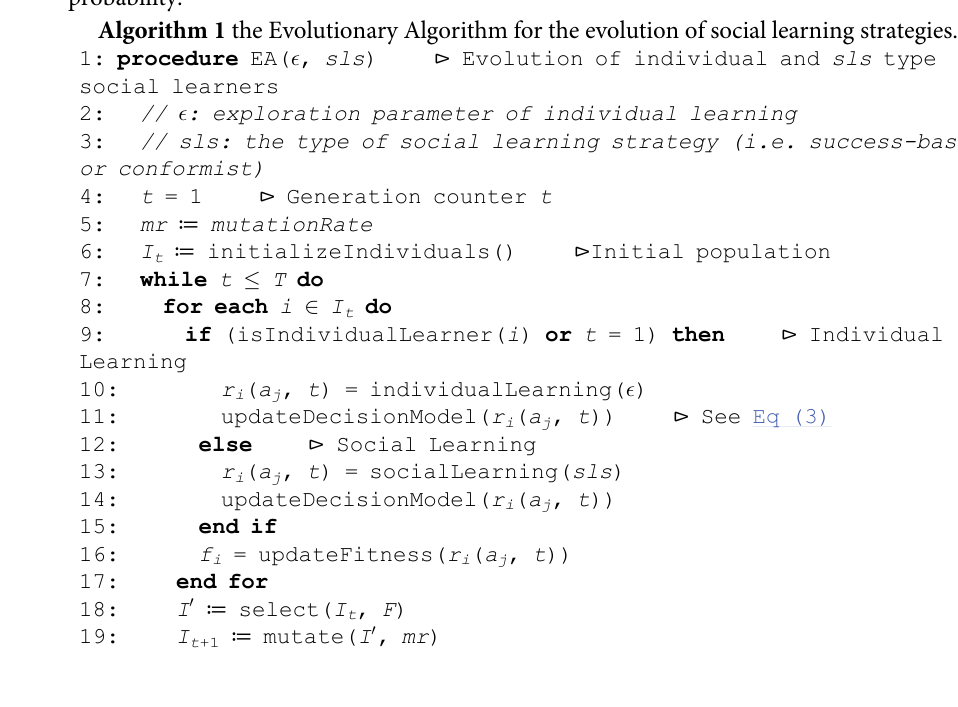
Algorithm 1 the Evolutionary Algorithm for the evolution of social learning